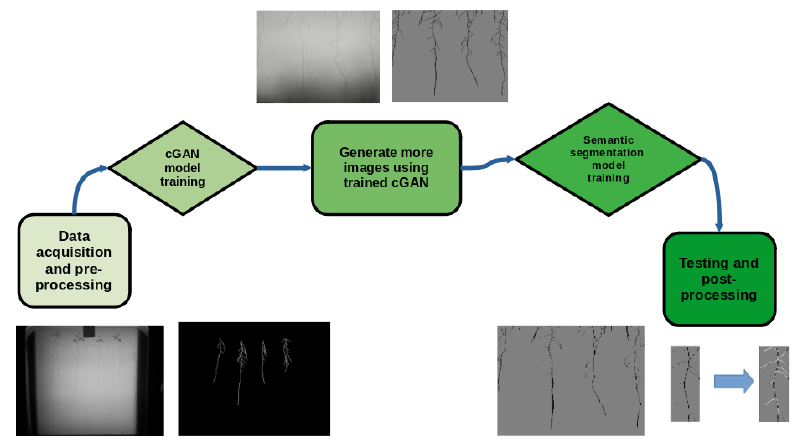
Figure 6. Summary of our methodology in this work.